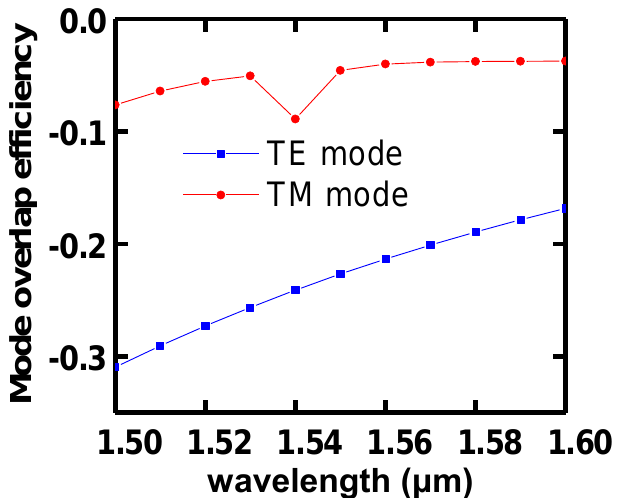
Figure 4. Wavelength dependence of mode overlap efficiency between the edge coupler facet and fiber.